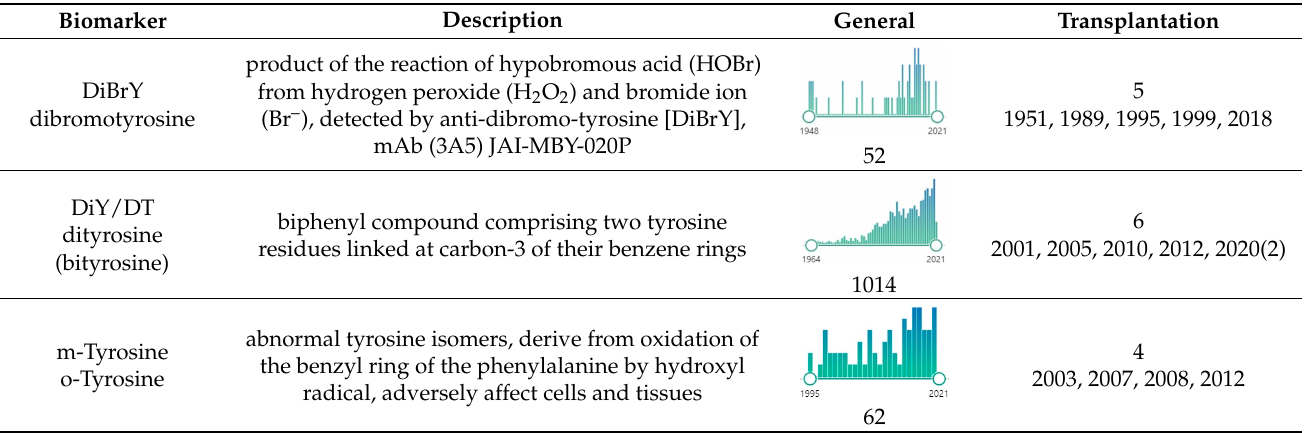
Table 4. Biomarkers of proteins peroxidation—description and research interest.